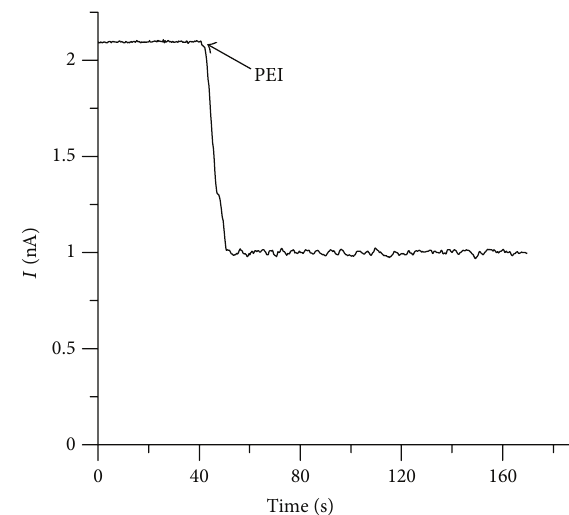
Figure 3: Addition of PEI (10 𝜇 M final concentration) to the cis side inhibits the macroscopic current through lysenin channels inserted in a neutral BLM biased by 30